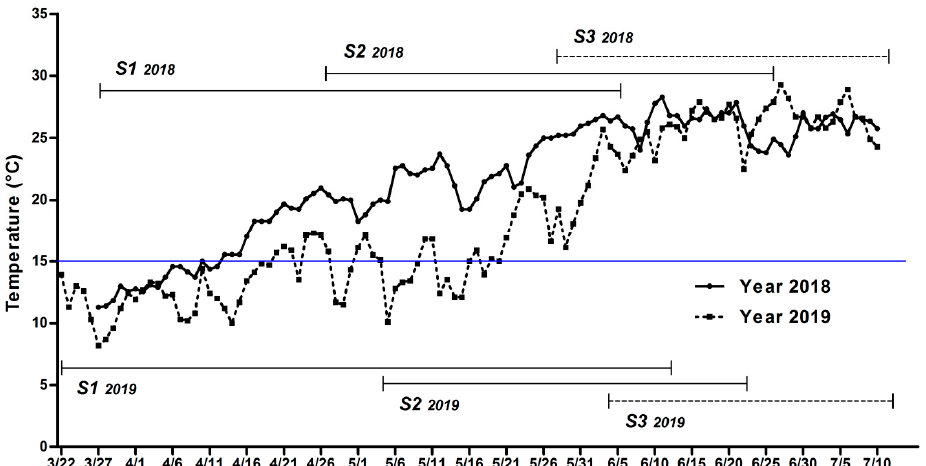
Figure 1. Average daily soil temperatures (2.5 cm depth) during the establishment period of three seeding times (S1, S2, and S3) in 2018 and 2019. The blue line corresponds to the base temperature for bermudagrass (15 °C).